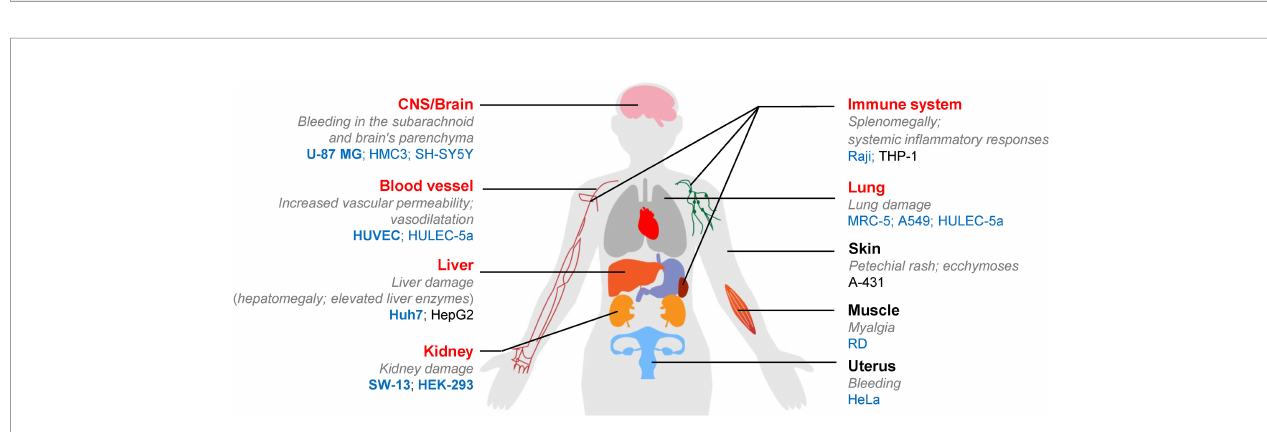
FIGURE 2 | Animal cell line susceptibility to CCHFV. (A) Animal cell line susceptibility to CCHFV was determined by IFA. Cells were infected with CCHFV at an MOI of 0.01 and CCHFV NP expression was detected at 4 d p.i. using IFA. Infected cells exhibited green fl uorescence (NP). Bars, 30 m m. (B) Animal cell line susceptibility to CCHFV as de fi ned by fold-change of viral loads. The different cell lines were infected with CCHFV at an MOI of 0.01. Supernatants were harvested at 4 d p.i. and evaluated using qRT-PCR. All experiments were performed in duplicate. Fold-change of viral loads were normalized to baseline viral load. (C) Electron micrographs of negative staining of CCHFV particles in cell culture supernatants from Vero E6. Bar, 50 nm.